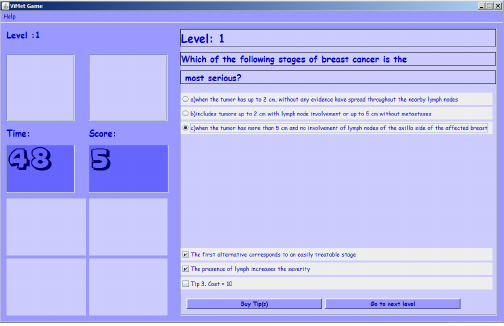
Figure 3. Example of the second phase of a ViMeTGame